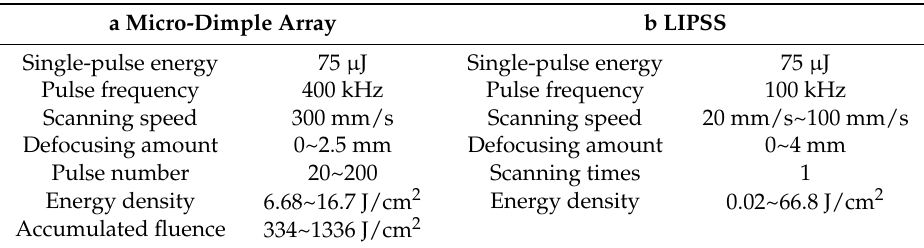
Figure 2. Schematic diagrams of the micro/nanostructure prepared by laser treatment on the Ti-6Al-4V surface. The scanning paths: ( a ) the micro-dimple array; ( b ) the LIPSS ripple; ( c ) hierarchical structure; ( d ) the 3D schematic diagram of a laser textured hierarchical structure. Table 1. Parameters of laser for preparing micron/nanoscale textures